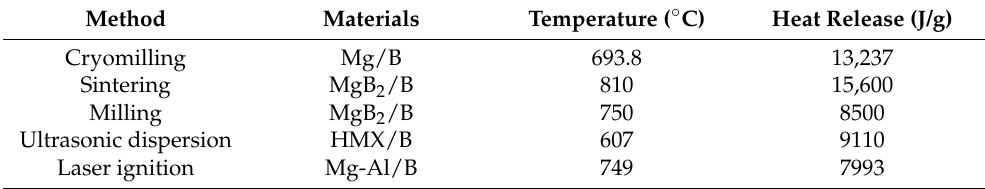
Table 5. The combustion behavior between B-based materials prepared by different method